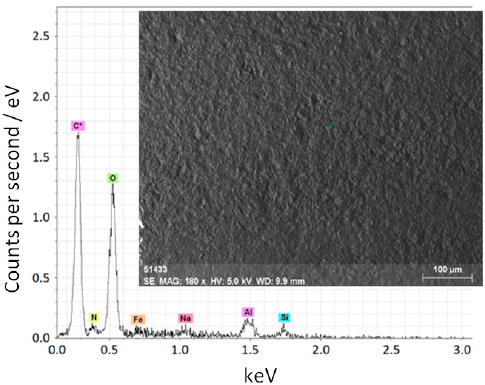
Figure 21. Elemental composition and micrograph of the initial aluminum oxide ceramics [134].